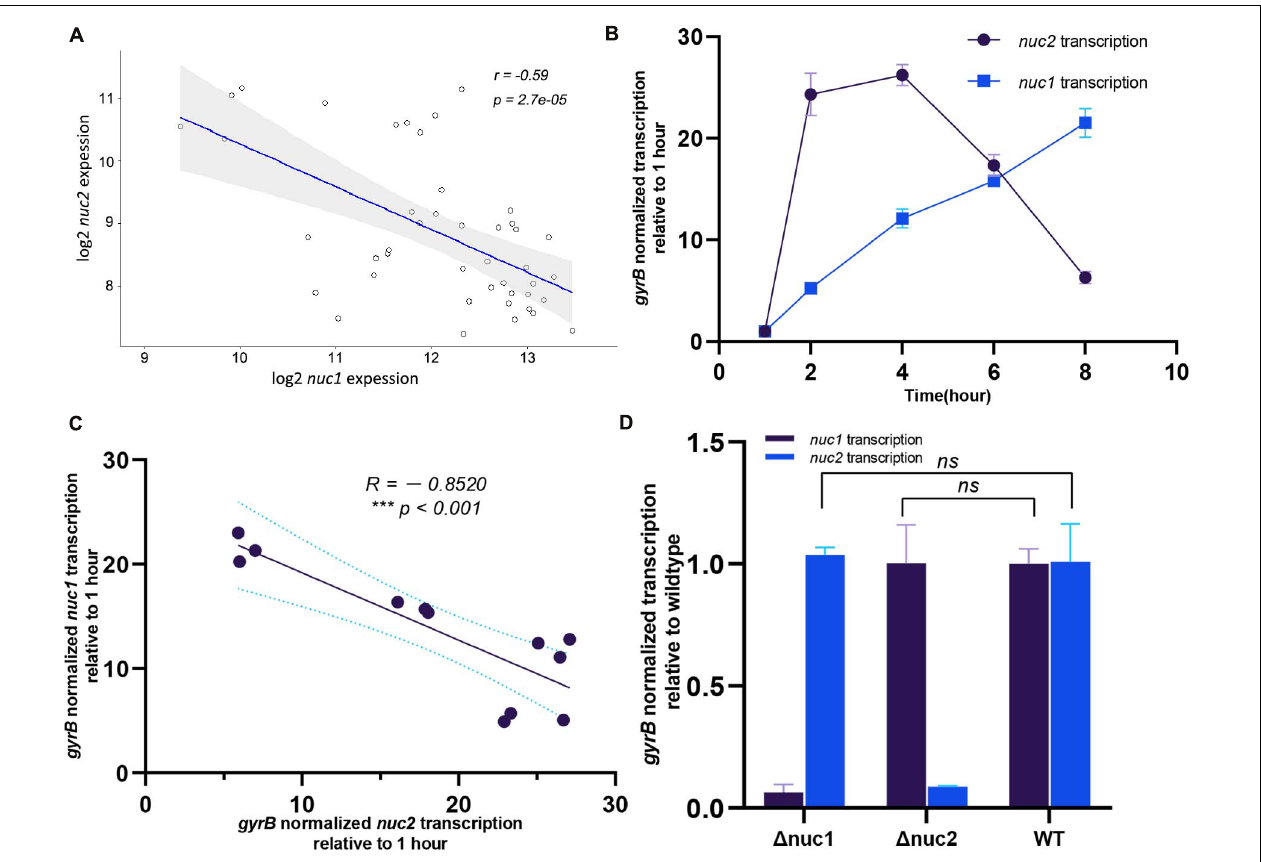
FIGURE 7 | Transcription relationship between nuc1 and nuc2 . (A) nuc1 and nuc2 correlation found by analyzing the publicly available data GSE25454. (B) Transcription levels of nuc1 and nuc2 in WT ST1792 at various time points determined through qPCR ( n = 3/time point). (C) Transcription levels of nuc2 at various time points (2, 4, 6, and 8 h) were related to nuc1 . (D) nuc1 and nuc2 transcription levels in ST1792 WT, (cid:49) nuc1 , and (cid:49) nuc2 determined using qPCR ( n = 3/group). A Pearson correlation test was performed in panels (A,C) , and unpaired Student’s t test was performed in panel (D) . TABLE 1 | Minimum Inhibitory Concentration and sub-MIC for strains tested # .